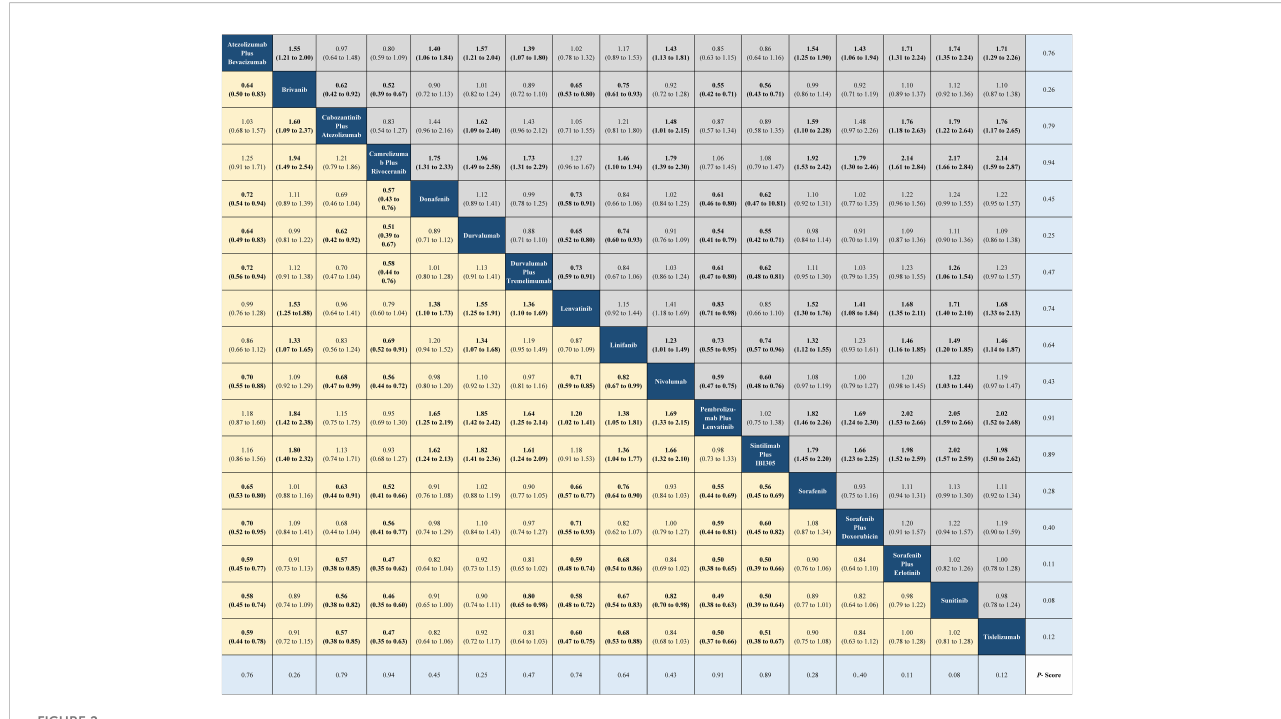
FIGURE 2 Network meta-analysis for progression-free